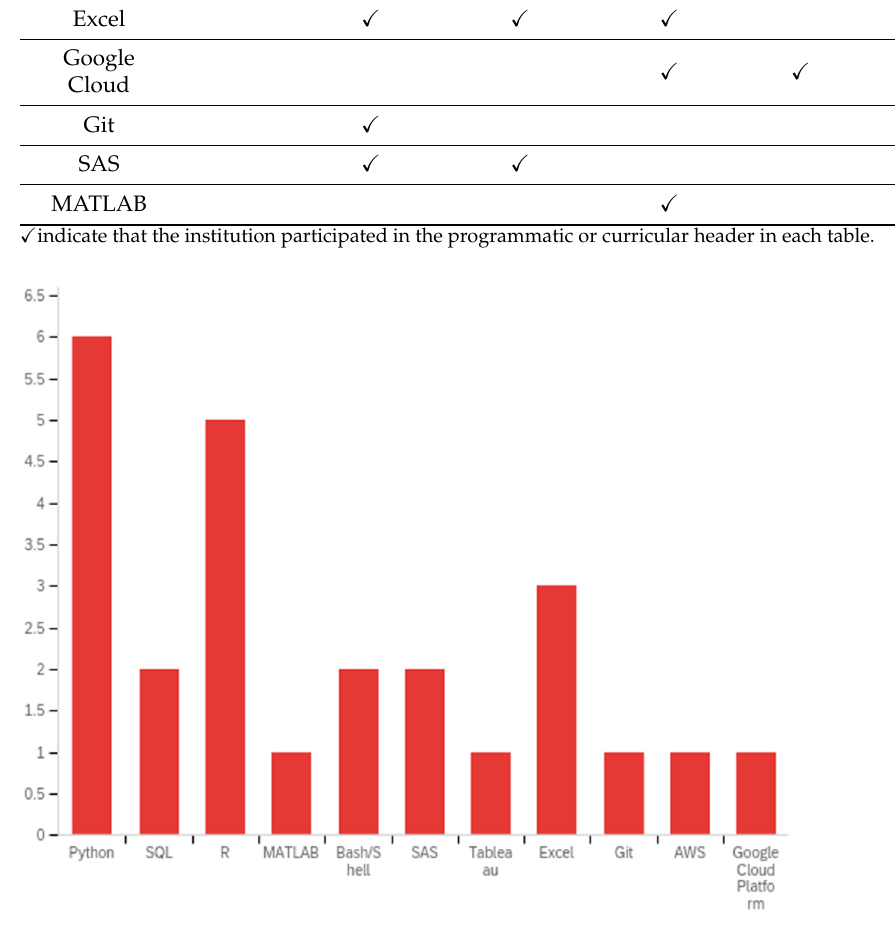
Table 5. Summary of program instruction.